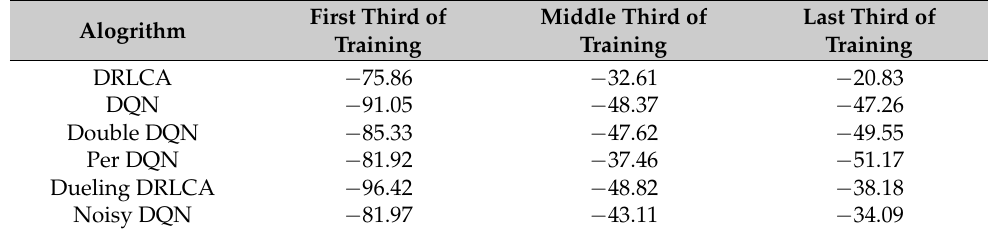
Table 2. Mean of rewards at different stages of training.